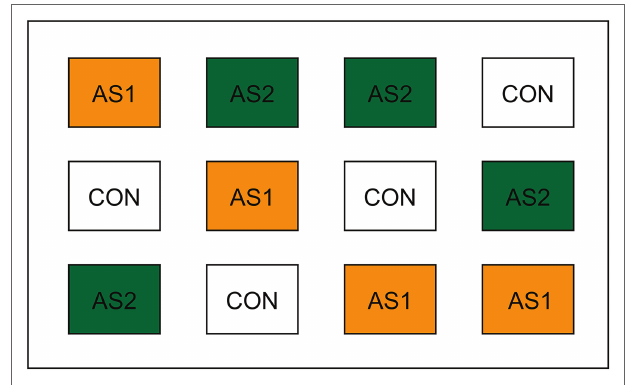
FIGURE 1 | Fertilizer application on the designed plots in 2017–2018 production seasons. CON, standard fertilization; AS1, manure-derived ammonium sulfate; AS2, manure-derived ammonium sulfate applied in split applications.